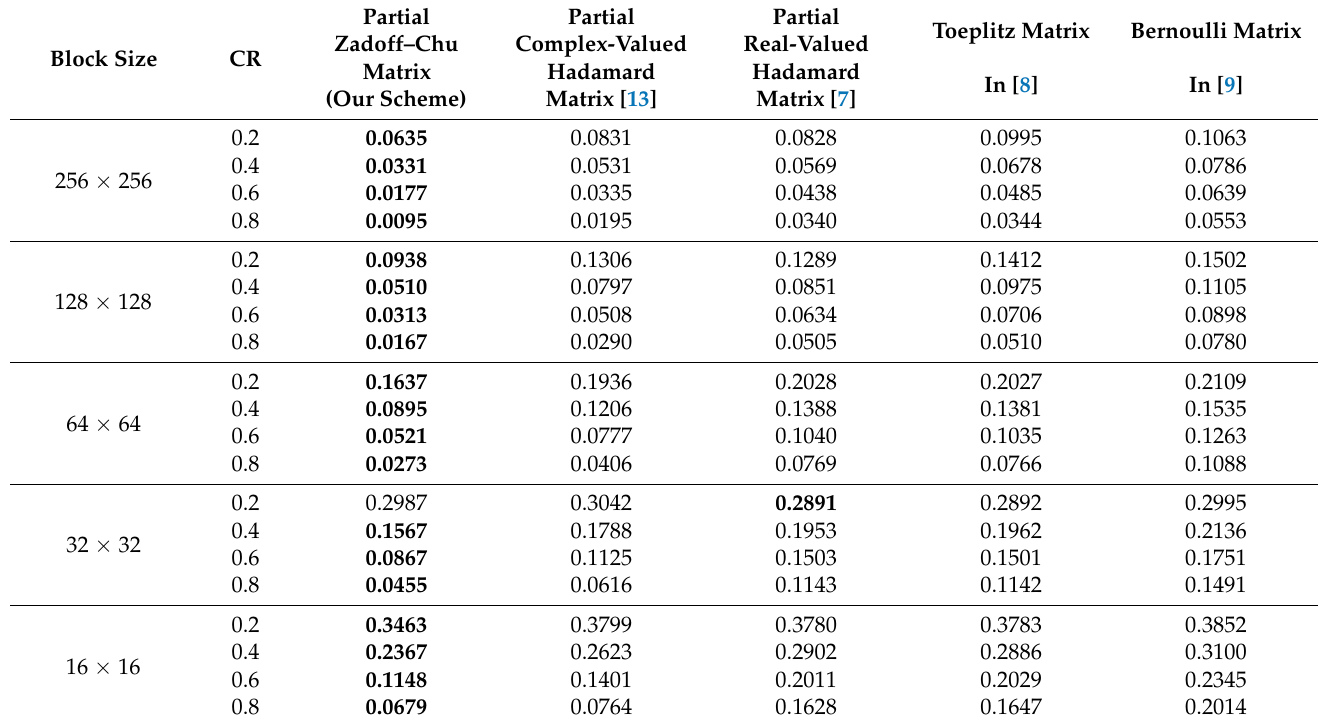
Table 1. Average mutual coherence of sensing matrix A for different measurement matrices. The bold indicates the smallest number (best one) of each